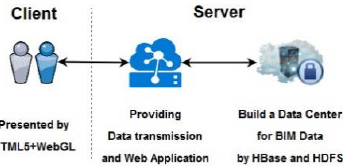
Figure 1. Taxonomy of Cloud computing (Chong et al., 2014) Chen et al. (2016) presented a Cloud-based system framework based on MapReduce and Bigtable as the data storage and processing paradigms for providing a web service for storing, viewing, and analysing massive Building Information Models (BIMs). Cloud, WebGL and Web 3D technologies were utilized to develop a BIM data centre that can be accessed by users to submit and view BIMs online in 3D.